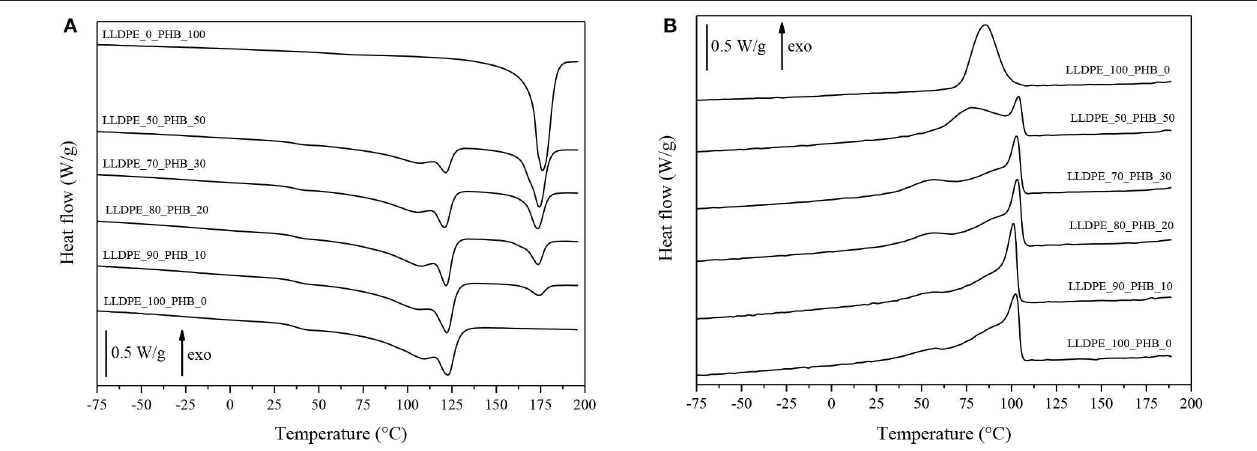
FIGURE 4 | DSC thermograms of neat LLDPE, neat P(3HB), and relative LLDPE/P(3HB) blends. (A) First heating and (B) cooling scan.